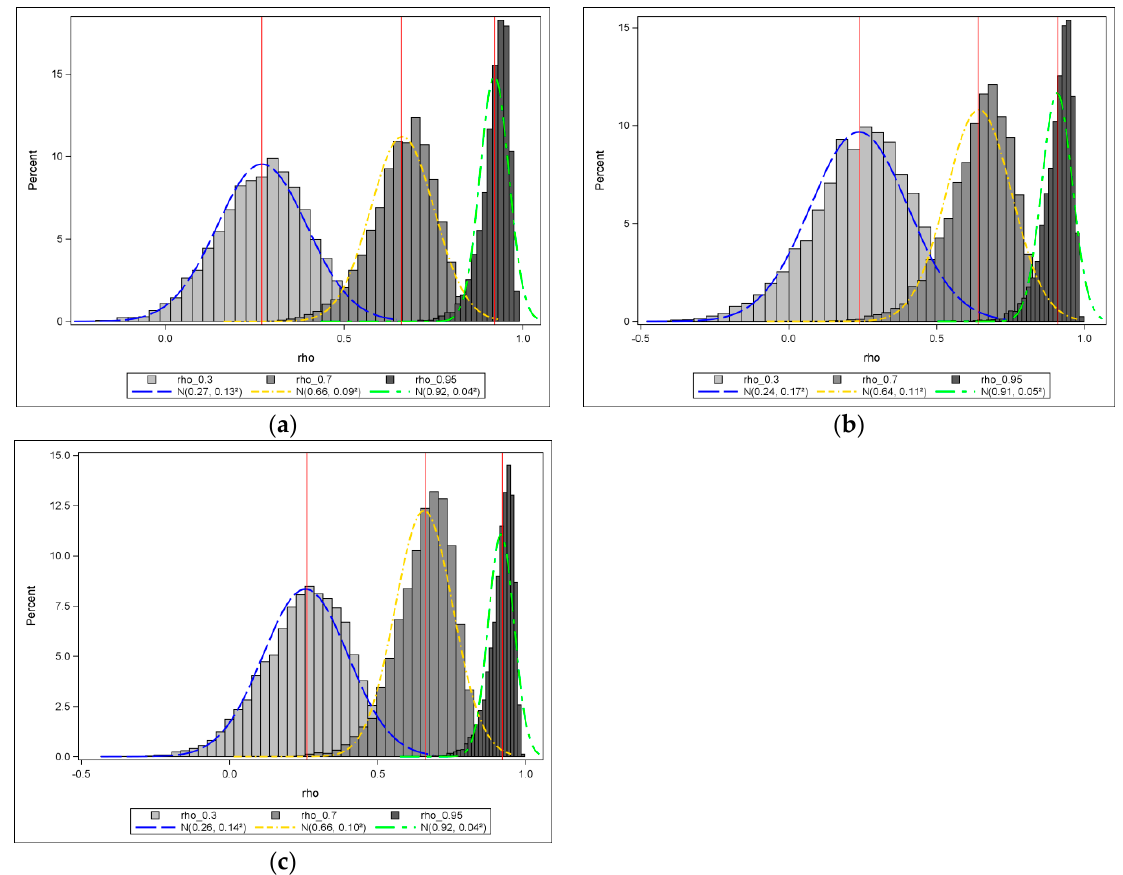
Figure A3. Frequency distributions of weak, moderate, and strong positive SA parameters: ( a ) square tessellation, rook adjacency; ( b ) square tessellation, queen adjacency; and, ( c ) hexagonal adjacency.